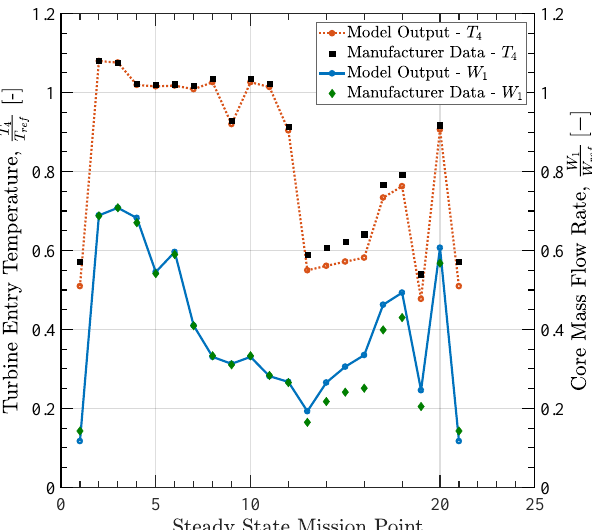
Figure 3. Validation of the RB211-524C NPSS engine performance model for turbine entry tempera- ture and core mass flow